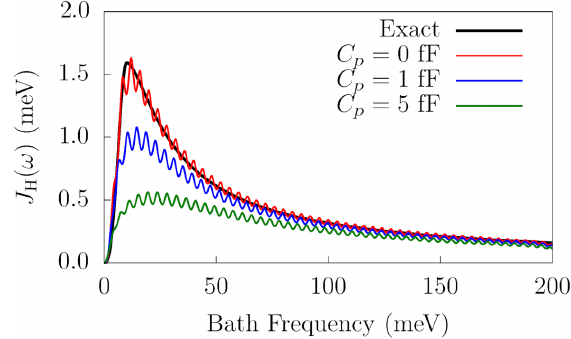
FIG. 6. The effect of parasitic capacitance on the bath spec- tral density realized by the QBS. The target spectral density J H (ω) (black) is discretized into 50 equally spaced RLC oscilla- tors with a fixed damping parameter of 2 meV (red) and parasitic capacitances of 1 fF (blue) and 5 fF (green) are added to each